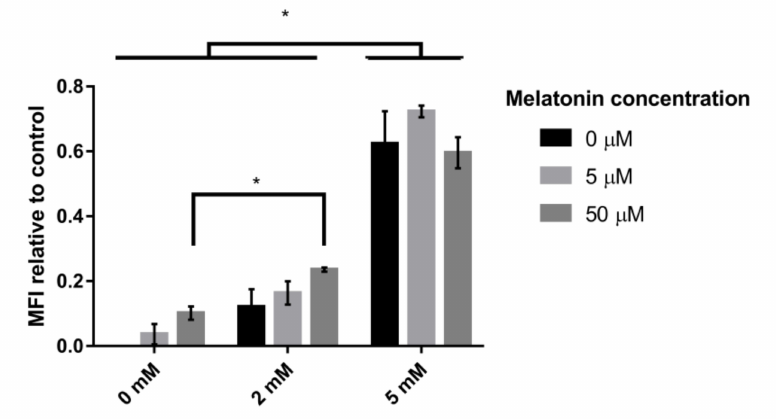
Figure 6. E ff ect of H 2 O 2 and melatonin on the number of mitochondria per cell. The values are expressed as the mean fluorescence intensity (MFI) of the di ff erent conditions compared to the control. The cells were incubated with di ff erent melatonin concentrations (0 µ M, 5 µ M and 50 µ M) and then subjected to treatment with di ff erent H 2 O 2 concentrations (0 mM, 2 mM and 5 mM). Error bars represent the standard deviation, and * indicates statistically significant di ff erences between media ( p <